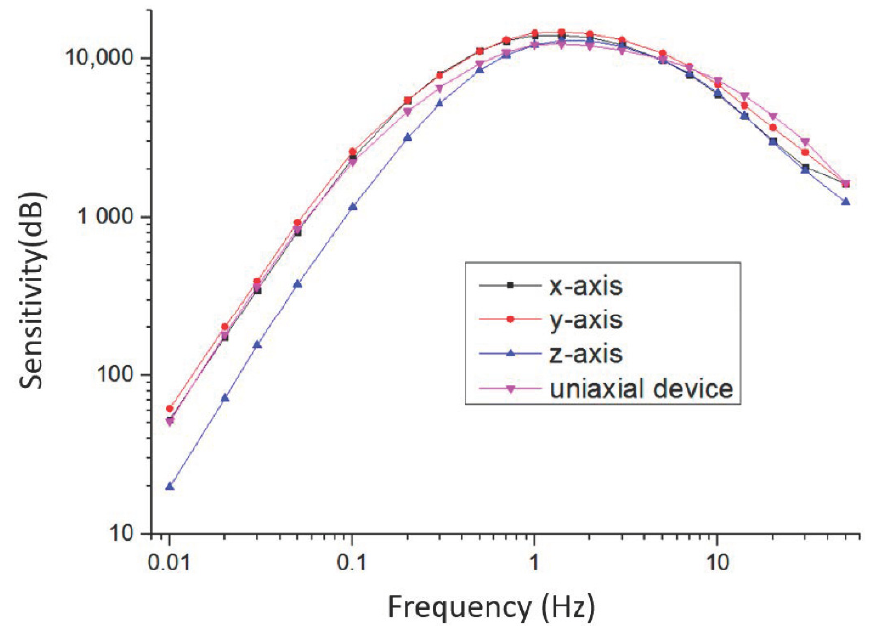
Figure 5. Measurement results of the sensitivity curves of x-, y-, and z-axes of the integrated triaxial device in comparison with the sensitivity curves of the uniaxial device.